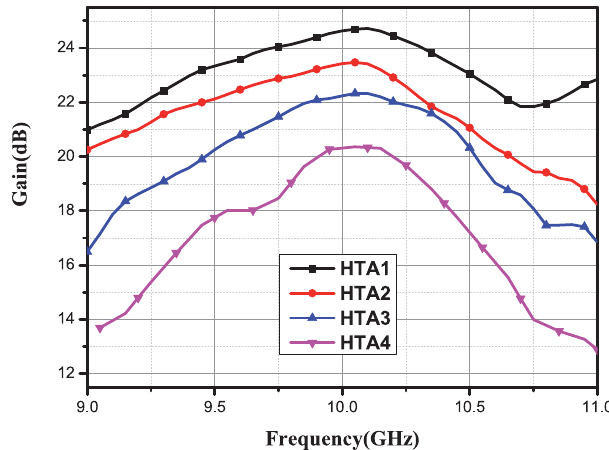
Fig. 11. Gain characteristics versus frequency of the four high- gain antennas.